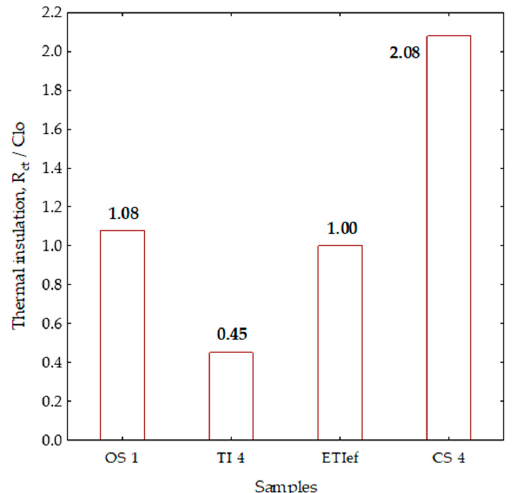
Figure 5. Presentation of the thermal insulation efficiency parameter (ETIef) calculated from the value of the thermal insulations of the clothing system (CS) and the outer shell (OS).